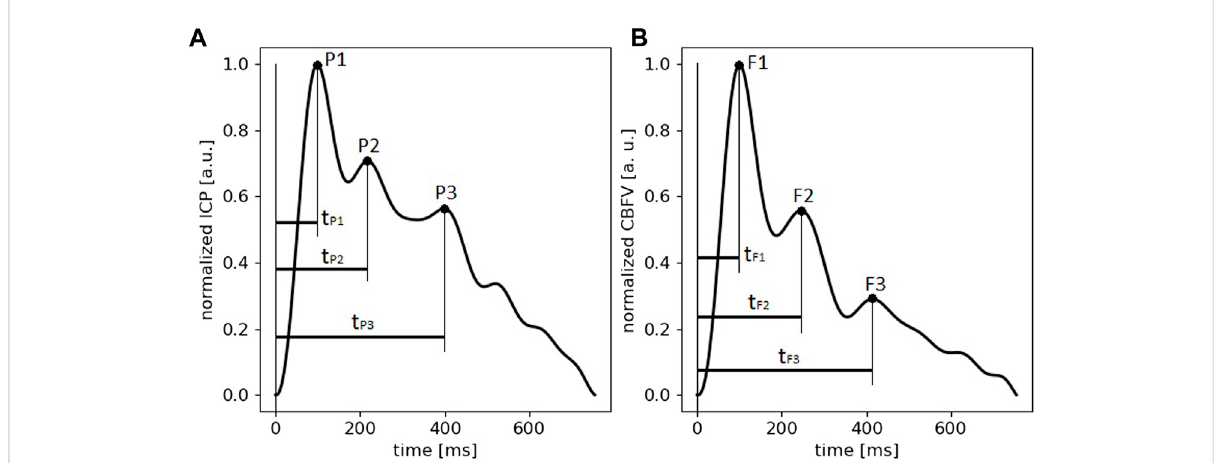
FIGURE 1 An example of normalized pulses of intracranial pressure (ICP) and cerebral blood fl ow velocity (CBFV) with annotated peaks (P1, P2, P3 for ICP